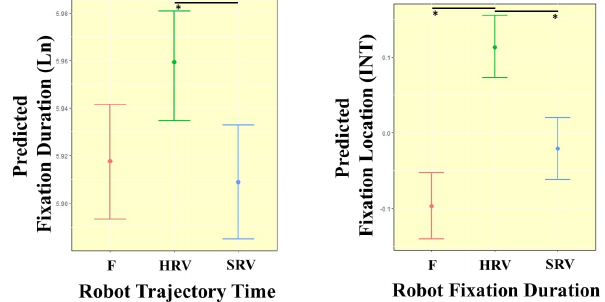
Figure 5: Fixation patterns across the study. Predicted values are plotted on the y-axes in order to facilitate the interpretation of re- sults. Vertical bars denote +/- 1 standard error. Horizontal bars de- note differences surviving post hoc comparison. Figure on the left shows Robot’s Trajectory Time (rTT) main effect on participants’ fix- ation duration (F: Mean=439ms, S.D.=309ms; HRV: Mean=460ms., S.D.=321ms; SRV: Mean=428ms, S.D.=275ms). Log-transformed (Ln)